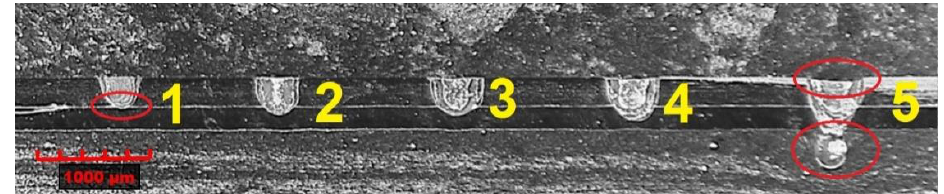
Figure 4. View of obtained welds for lap joints in cross-section.